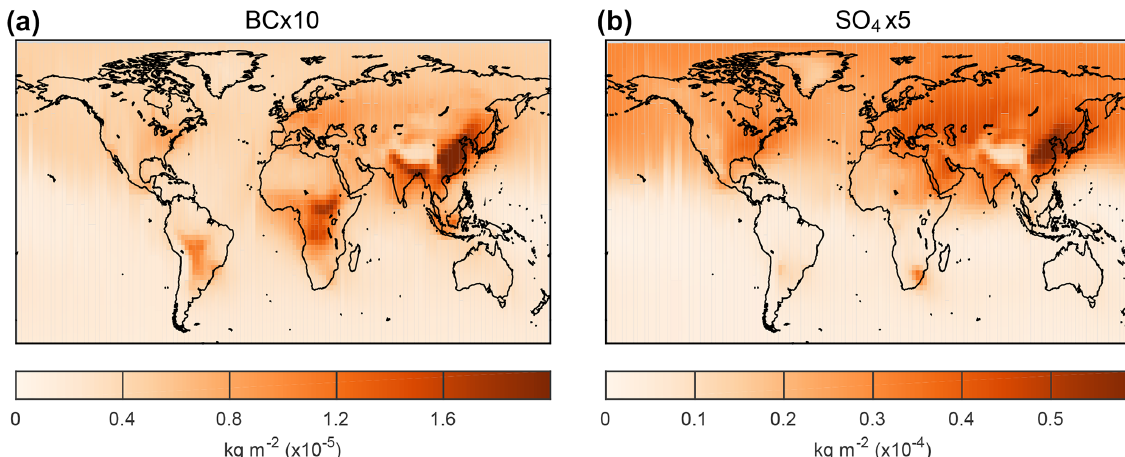
Figure 1. Aerosol loadings for the two aerosol experiments in the CanESM2 model (as an illustrative